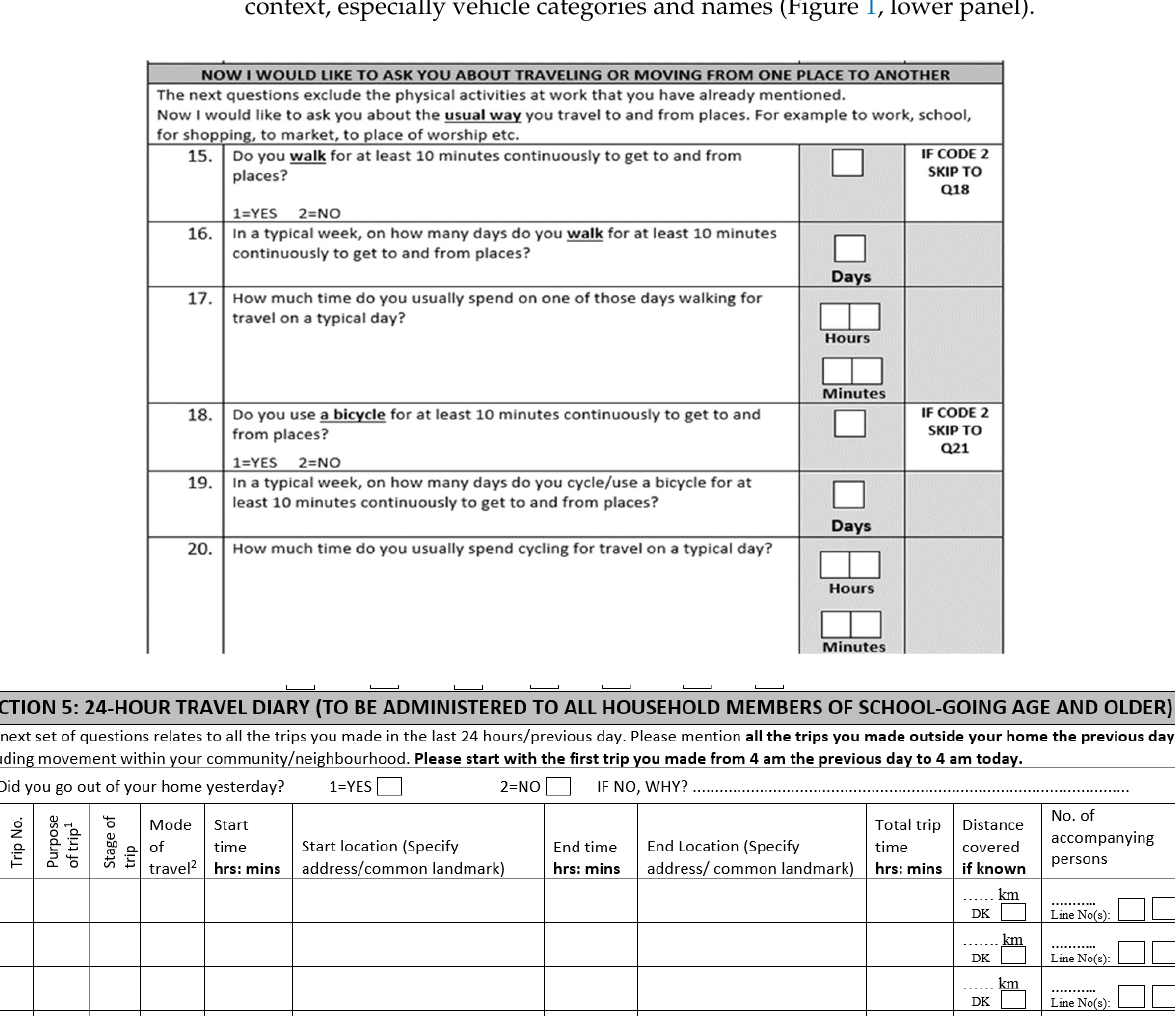
Figure 1. Excerpts of survey questionnaires. The GPAQ (upper panel, which captures data on a typical day and week) shows separate questions for walking and cycling. The travel diary (lower panel, captures data on a specific day, say yesterday) shows included variables.